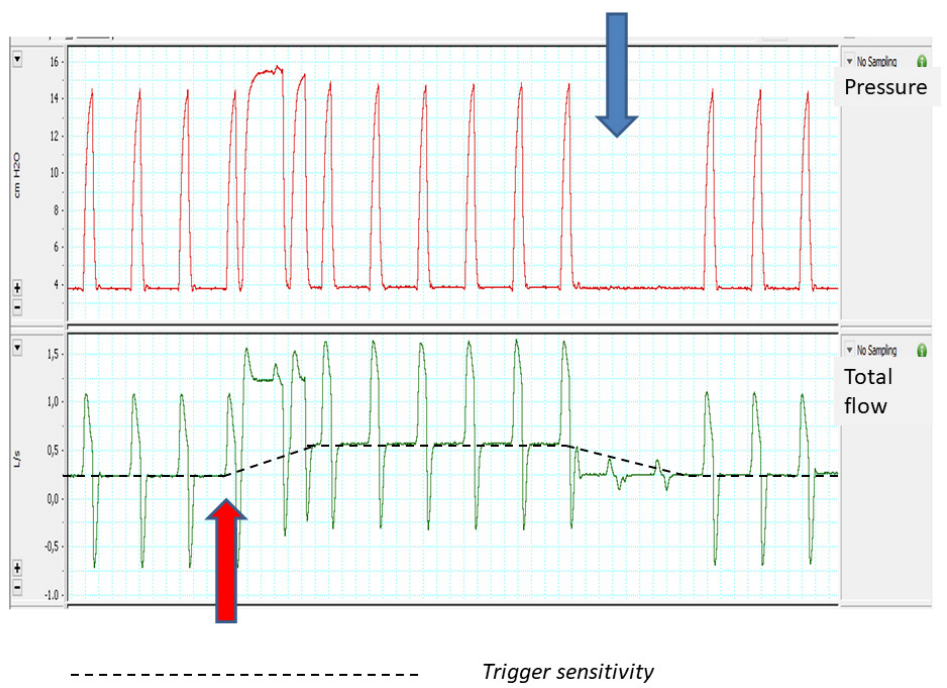
Figure 1. E ff ects of leakage on fl ow triggering function (see the text for more details). Figure 1. Effects of leakage on flow triggering function (see the text for more